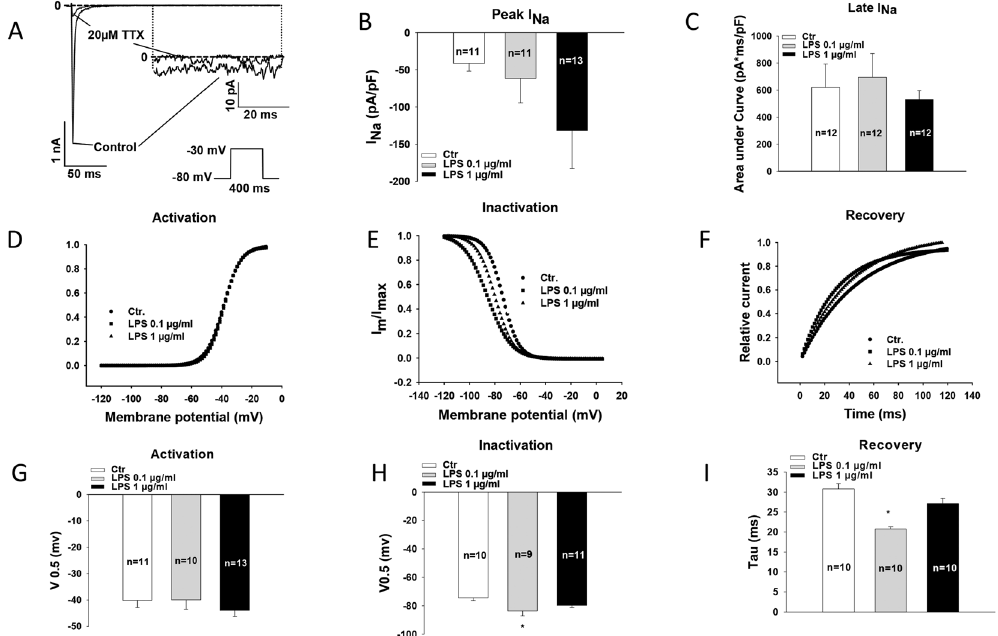
Figure 6. Effects of LPS on I Na . ( A ) Representative traces of I Na at − 30 mV in absence and presence of 20 µ M TTX. ( B ) Averaged peak I Na at − 30 mV in control and LPS-treated hiPSC-CMs. ( C ) Averaged values of late I Na at − 30 mV. ( D ) Representative activation curves of peak I Na . ( E ) Representative inactivation curves of peak I Na . ( F ) Representative curves of recovery from inactivation of peak I Na . ( G ) Mean values of voltages at 50% of steady-state activation of peak I Na (V0.5). ( H ) Mean values of voltages at 50% of steady-state inactivation of peak I Na . ( I ) Mean values of time constants (Tau) of recovery from inactivation of peak I Na . Values given are mean ± SEM. n, number of cells. * p <